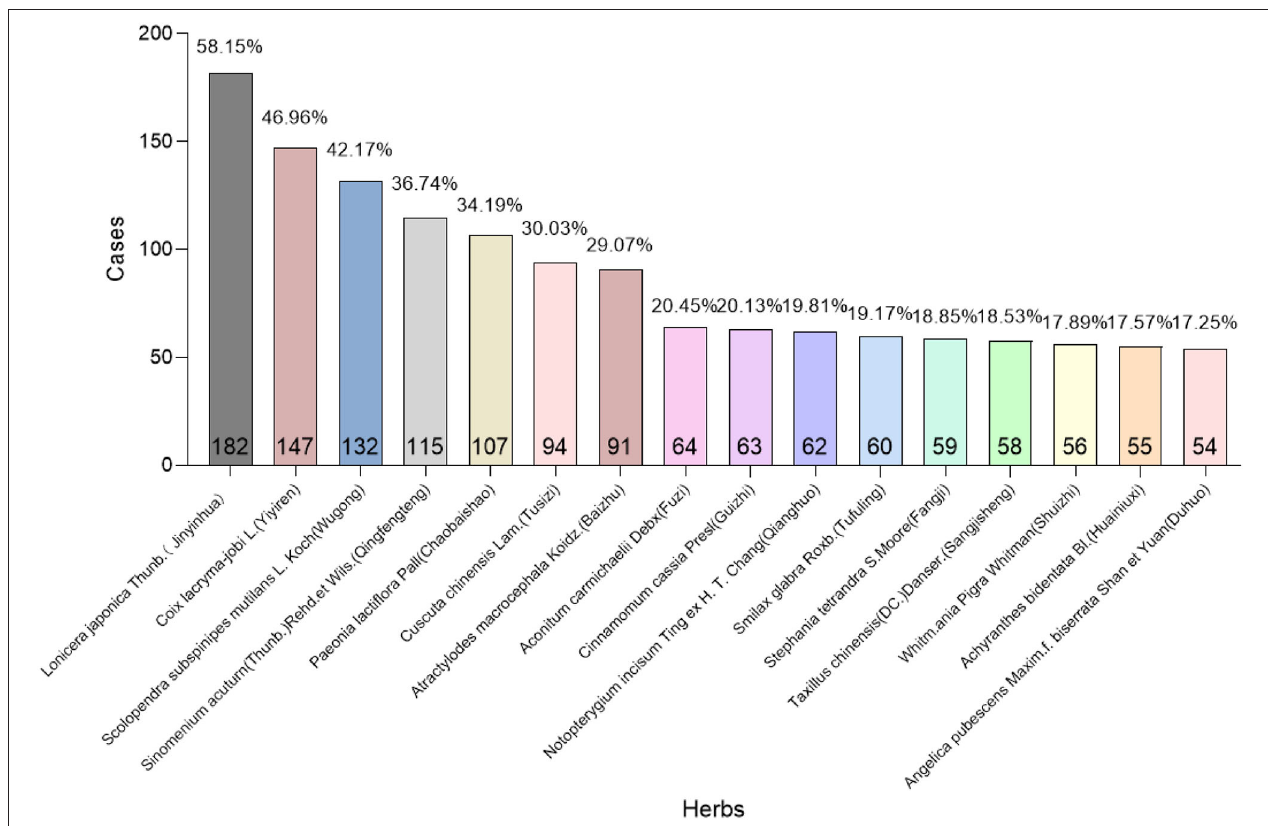
FIGURE 4 | Screening of high frequency used herbs. X -axis: High frequency used herbs; Y -axis: Total times as well as its frequency that each herb appeared in 311 cases (At the bottom and top of the column, respectively). Herbs with their frequencies higher than 10% were enrolled in this study.